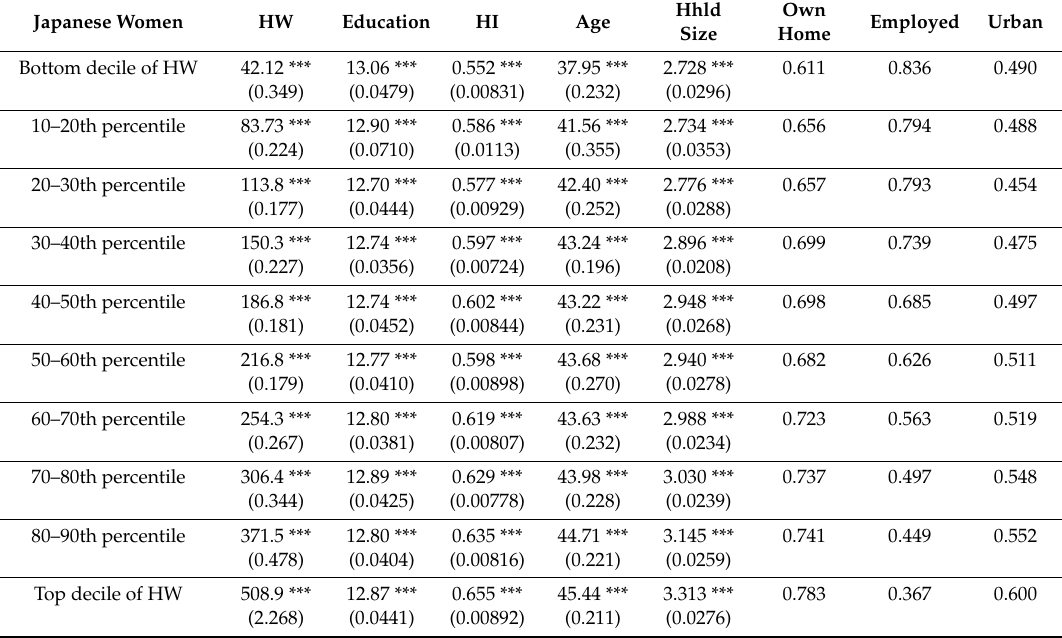
Table 1. Pooled descriptive statistics, 20 to 60-year-old women, Japan 2006.